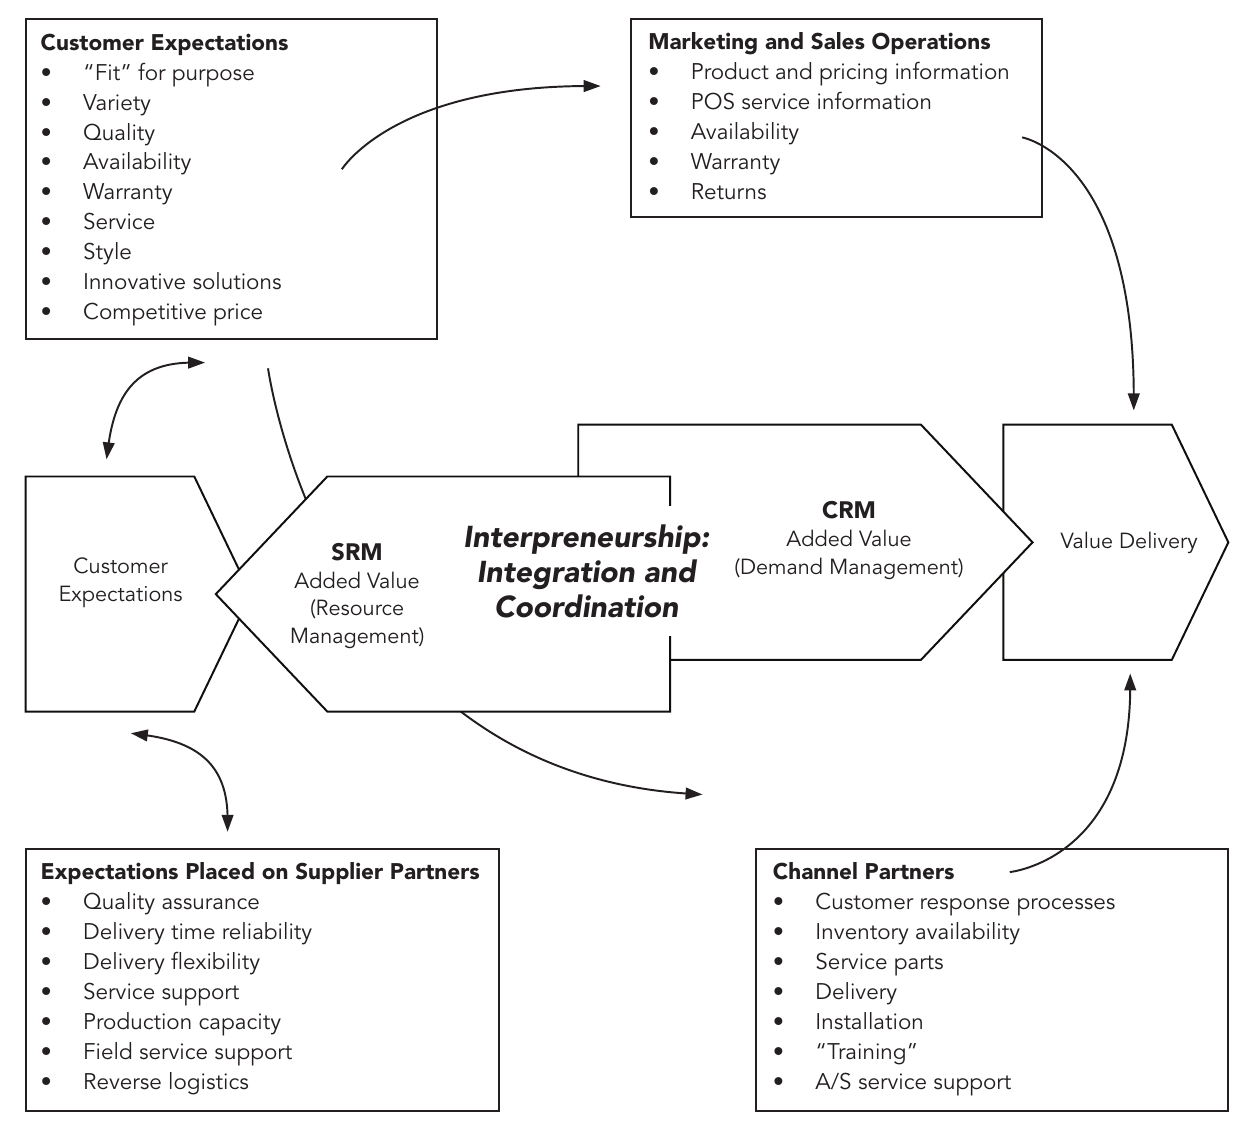
Figure 5: The elements of a value